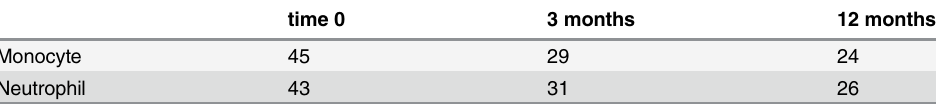
Table 2. AAV pre- and post-treatment sample sizes.